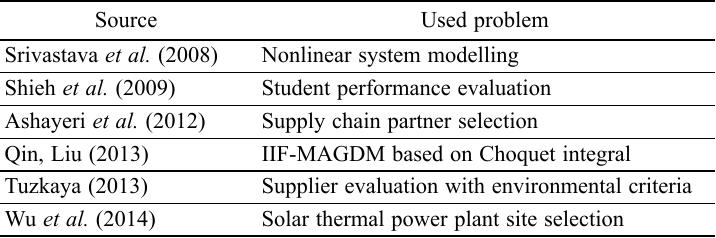
Table 2. Application of Choquet operator in decision-making problems Source Used problem Srivastava et al.